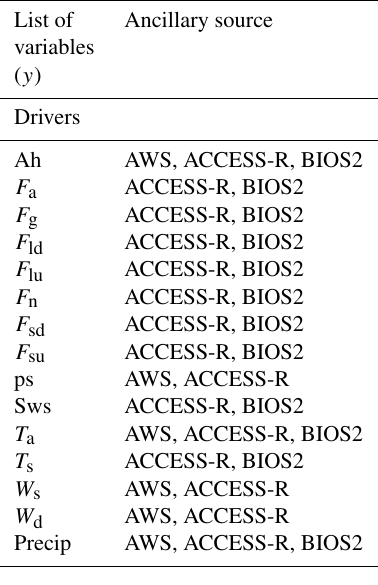
Table 3. The ancillary sources used to gap-fill each environmental